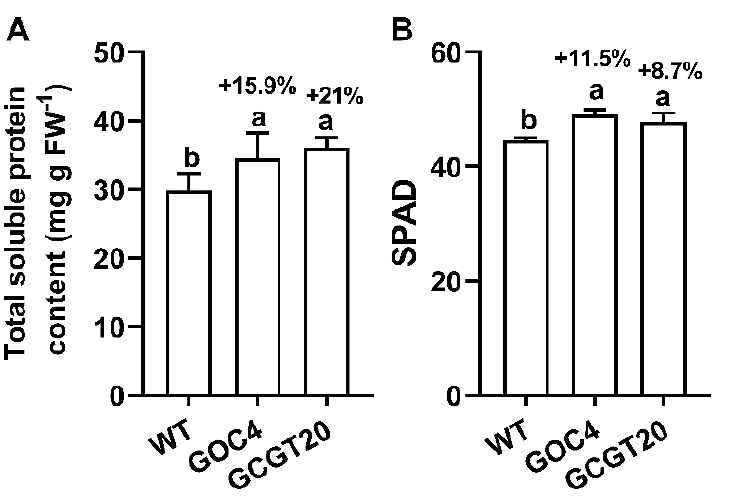
Figure 5. Total soluble protein content and chlorophyll contents for GOC4, GCGT20, and WT plants. ( A ) Total soluble protein content; ( B ) chlorophyll content is estimated by SPAD. Data are presented as the mean ± SD and according to one-way ANOVA followed by a Duncan’s test for means comparison. Different letters indicate significant differences ( n = 4, p <